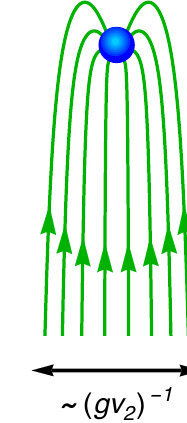
Figure 1 . Left : a schematic picture of the string configuration attached to a monopole. The sphere is shown as an eye-guide and is divided into the two hemispheres. The monopole is placed at the center of the sphere. The attached cosmic string with n = 2 extends to z < 0 direction (green rod). The arrow shows the direction of the circular current inside the string. Right : the magnetic flux of U(1) in the configuration. The magnetic flux is spherical for r (cid:29) ( gv ) − 1 while it is confined into D 2 the cosmic string. The size of the magnetic monopole (the blue point) is of ∼ ( gv ) − 1 . Inside the 1 monopole, the magnetic flux of U(1) is not D